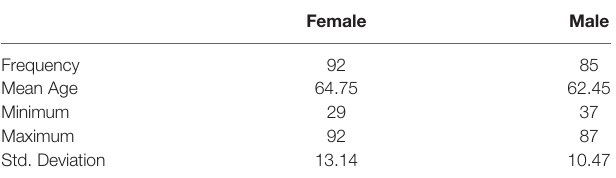
TABLE 3 | Patient and age distribution of the patient cohort.